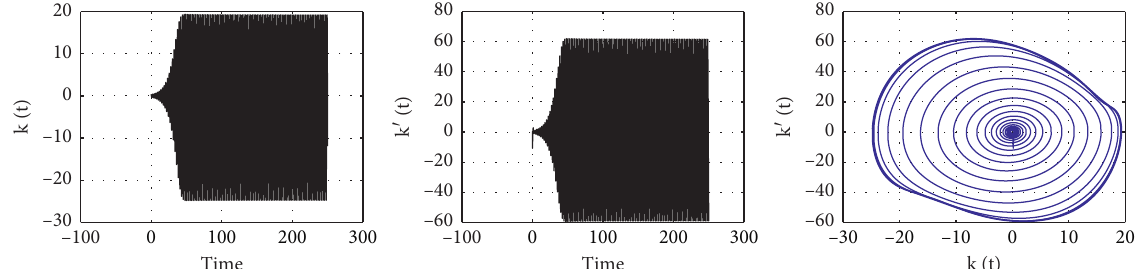
Figure 11: Solutions and phase trajectories at a � 0.125, q � 0.5, and τ � 1.